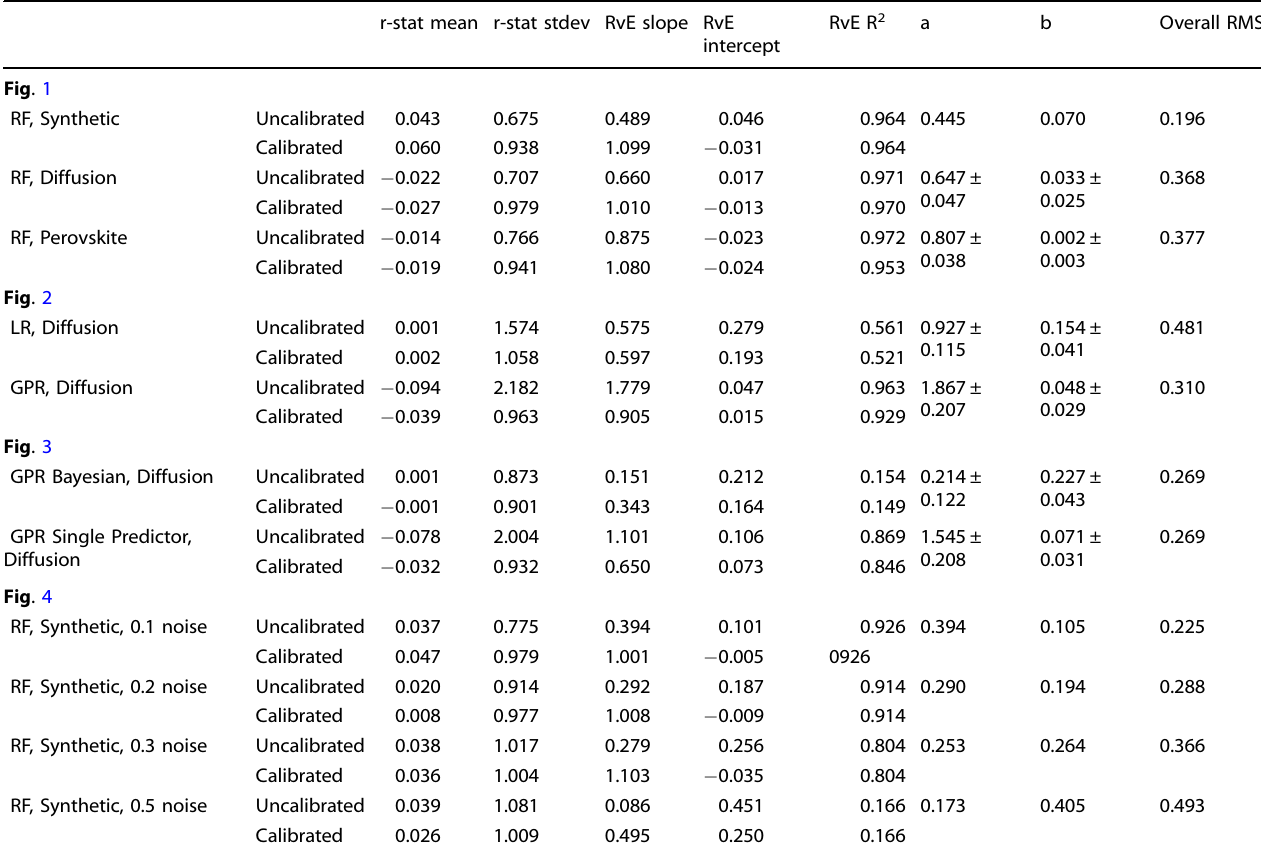
Table 1. Summary of computed values from Figs. 1 – 4.